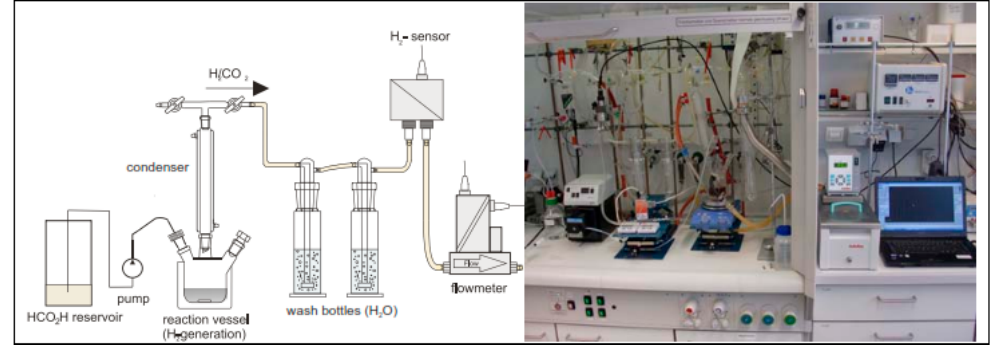
Figure 14. Experimental setup for continuous hydrogen production via FA dehydrogenation. Figure adapted from Reference [43].